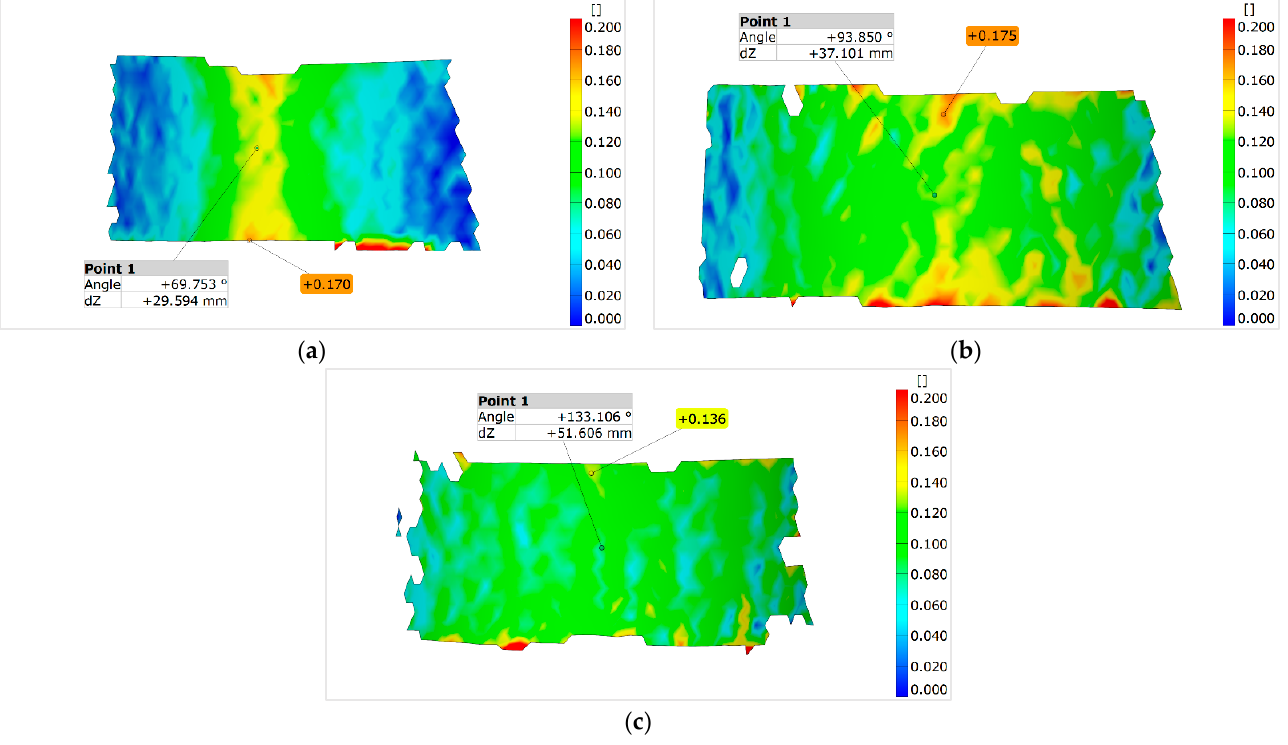
Figure 12. True strain field before fracture initiation of 4 mm test specimens; ( a ) R10; ( b ) R15; ( c ) R20.